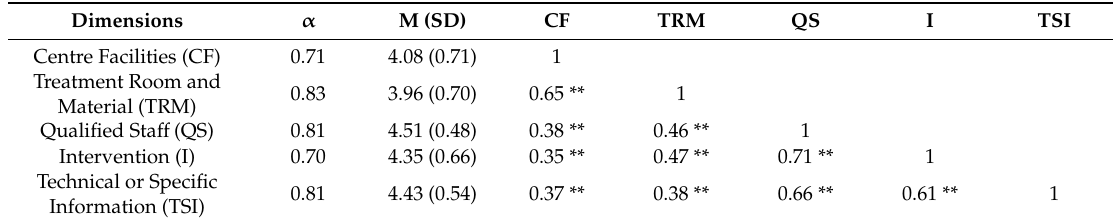
Table 2. Internal consistency, descriptive analysis and correlations between dimensions.